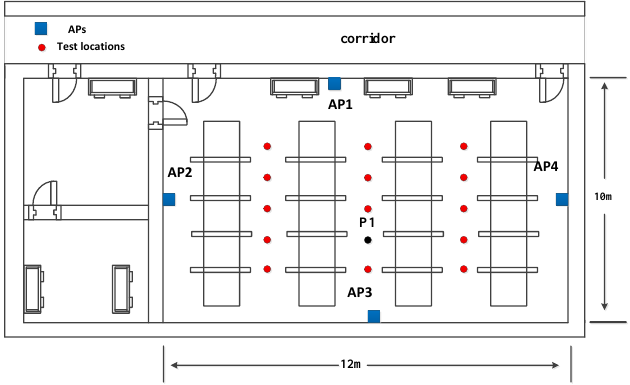
Figure 11. Geometrical structure of the testbed.